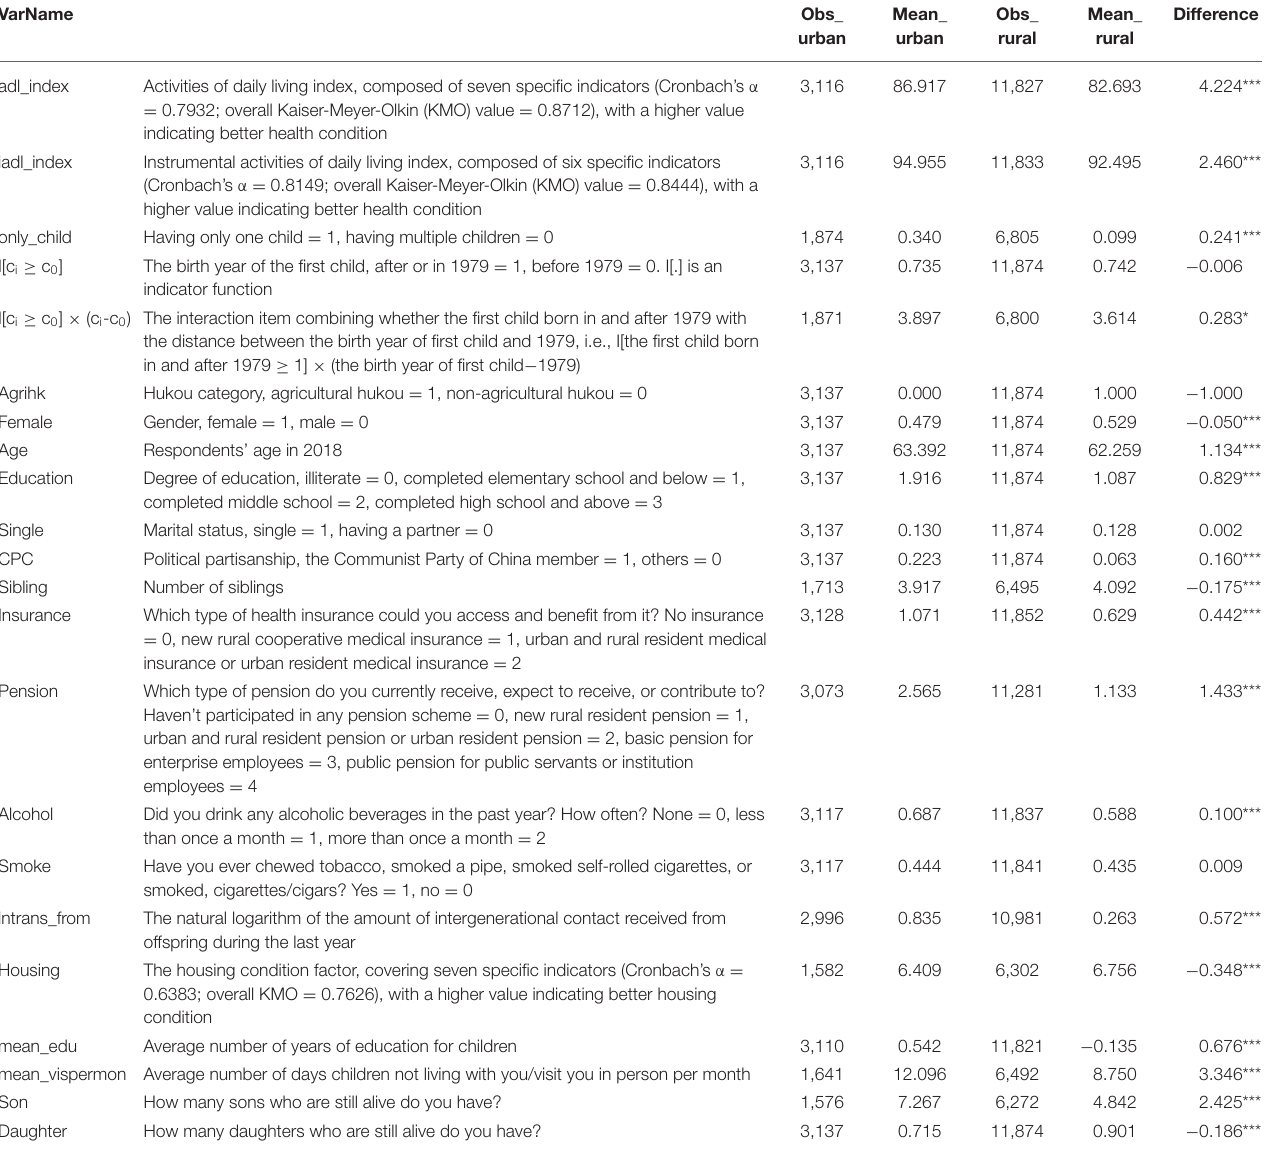
TABLE 1 | Descriptive statistics of mainly used